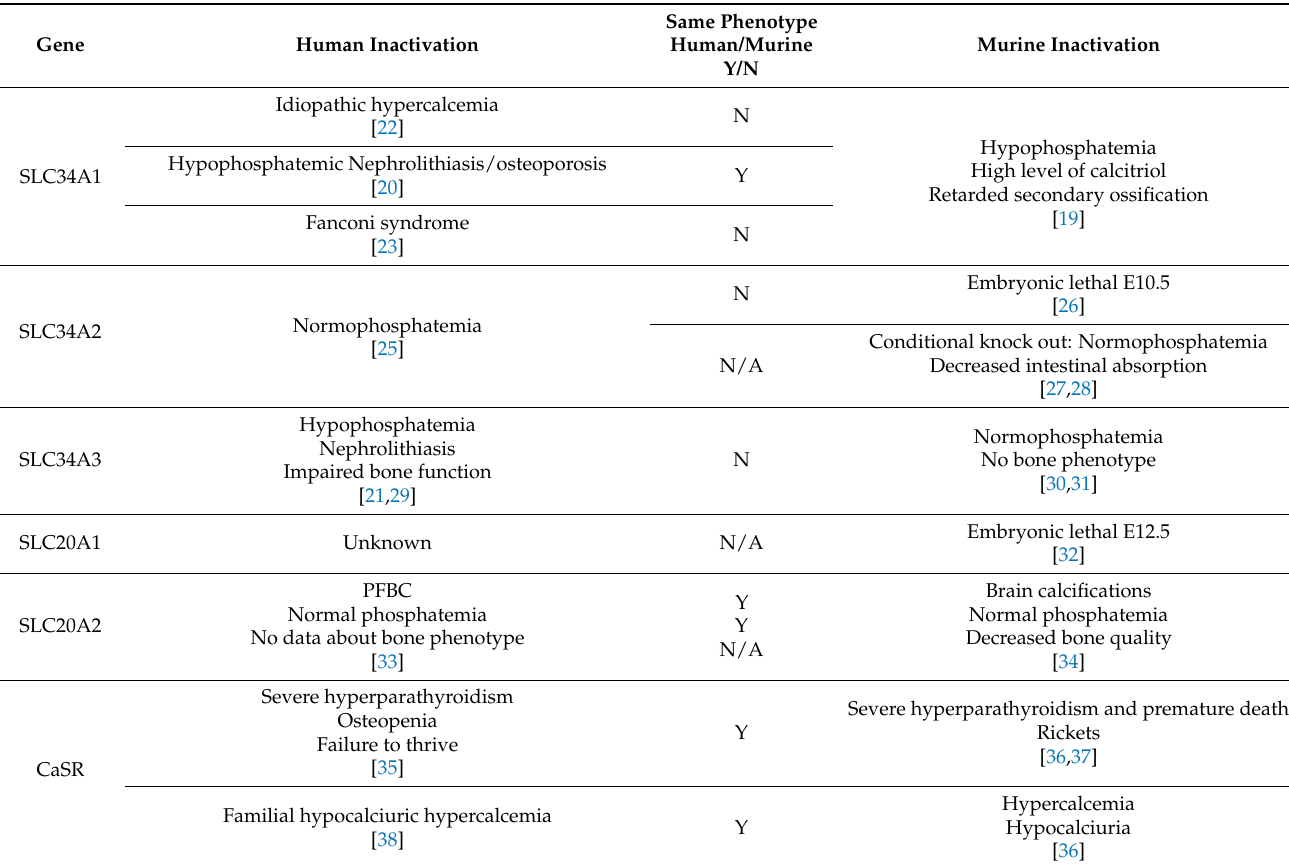
Table 1. Comparison of human and murine phenotypes following the inactivation of key phosphate transporters and phosphate